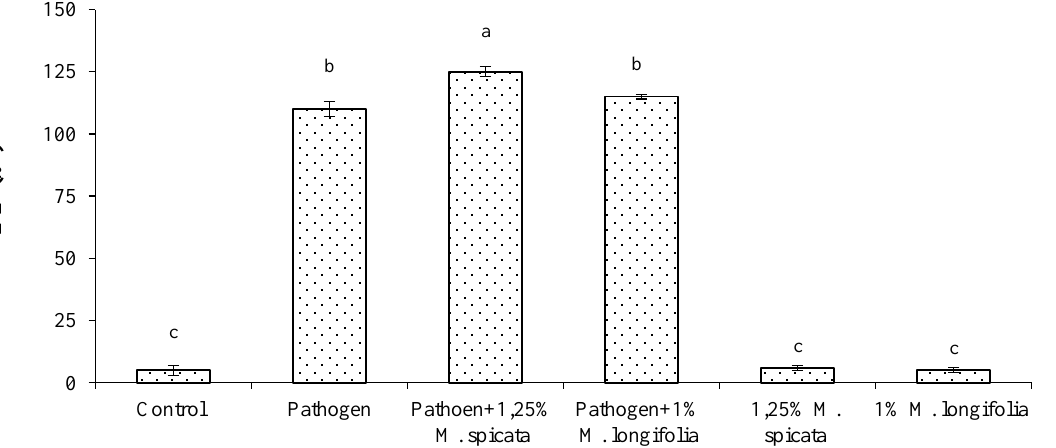
Figure 6. Effects of highest concentrations of M. spicata and M. longifolia EOs on electrical leakage percentage (EL%) in L. esculentum seedling leaves under Fusarium root rot disease conditions. Bars with different letters indicate significant differences between treatments at p ≤ 0.05. Data are expressed as the mean of three replicates ± SDs.